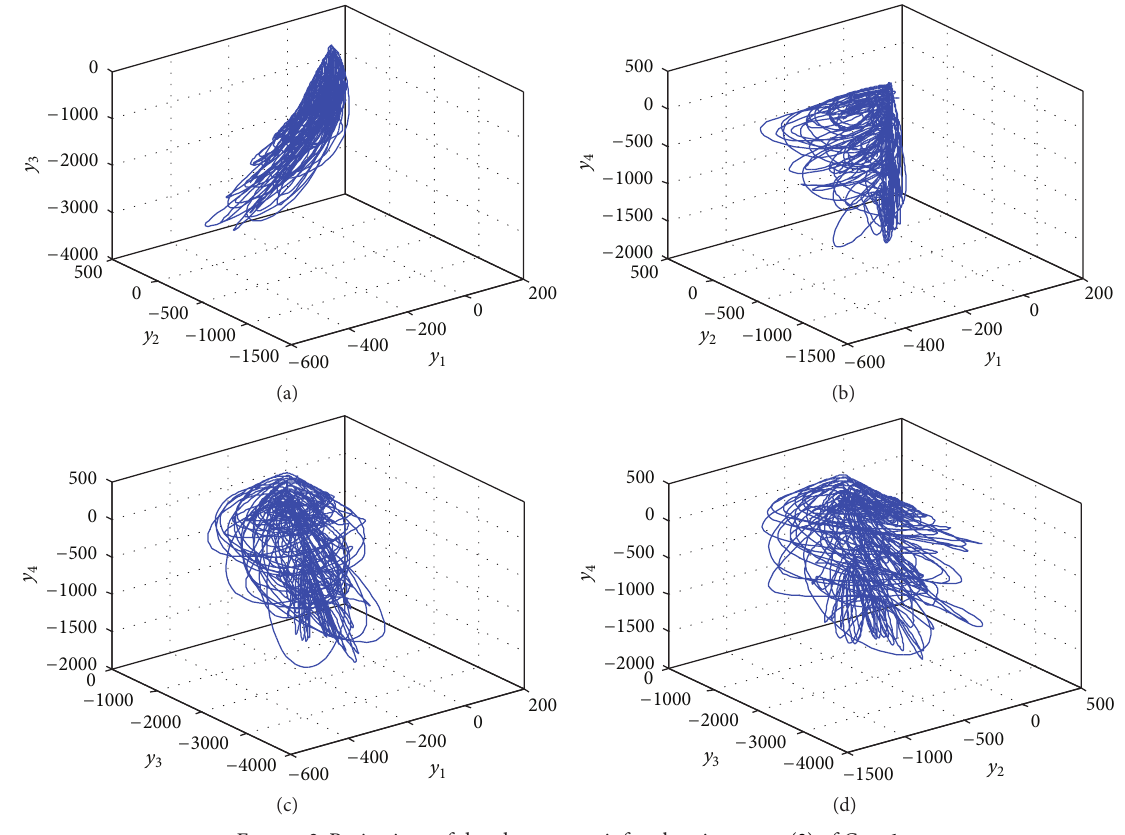
Figure 2: Projections of the phase portrait for chaotic system (3) of Case